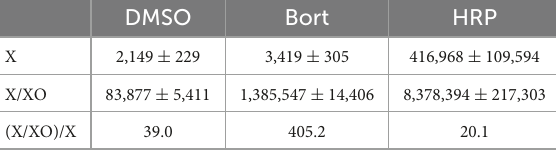
TABLE 2 Effects of bortezomib (Bort, 10 µ M) or HRP (0.1 U/ml) on L-012 luminescence in the X/XO